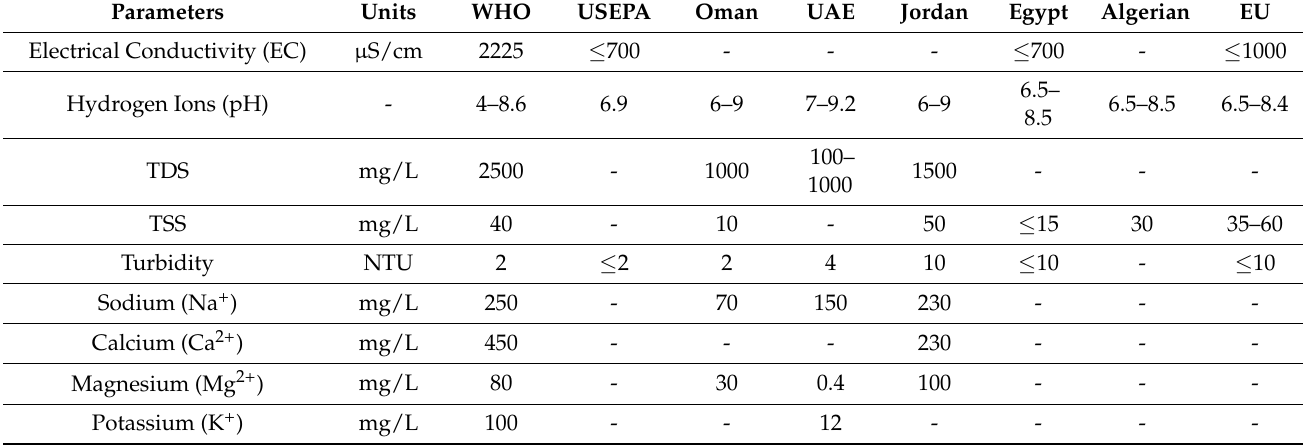
Table 14. Threshold limits of wastewater for reuse applications standardized by the World Health Organization (WHO), United States Environmental Protection Agency (USEPA), Oman, UAE, Egypt, and Algerian Standards guidelines